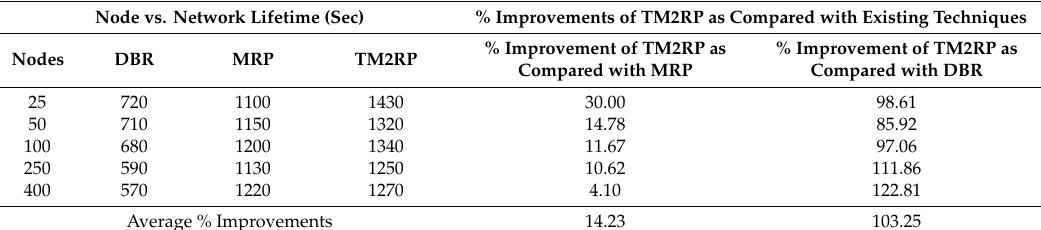
Table 4. The obtained results of TM2RP with regard to network